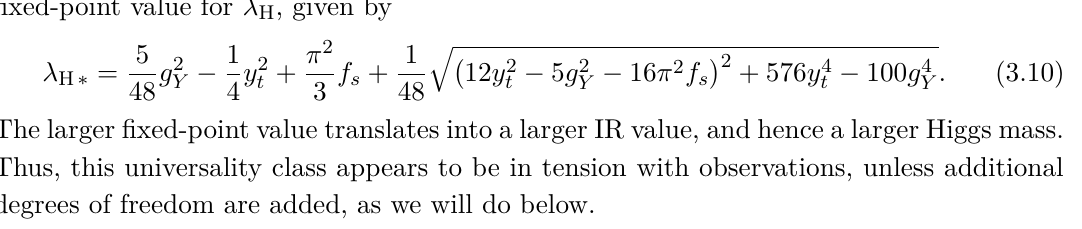
which encodes the s Λ ) . The grey region ∗ , ∗